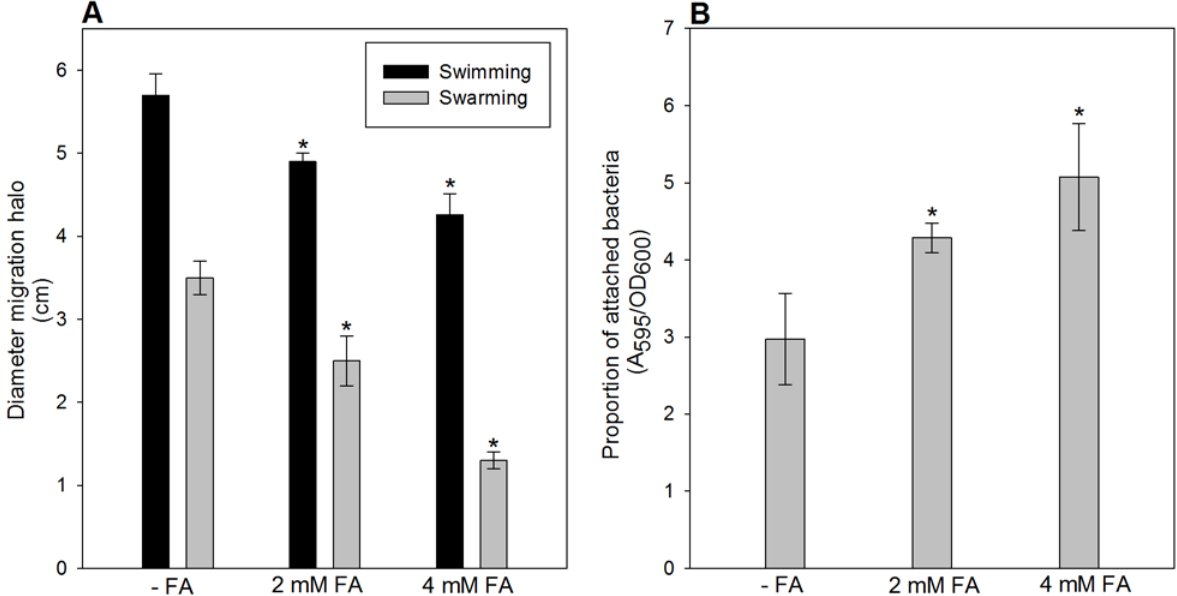
Figure 2. Effect of FA on cell motility and biofilm formation by P. protegens Pf-5. A . Cultures of P. protegens Pf-5 (wild type) were grown aerobically overnight to OD = 3 in KMB medium. An aliquot was spotted onto the centre of plates containing 20 fold diluted KMB medium supplemented or not with FA and solidified with various concentrations of Bacto-Agar, depending on which motility was to be evaluated. After 24 h of incubation at room temperature, the distance of the migration front from the point of inoculation was measured. B . Cultures of P. protegens Pf-5 were grown in 96-well polystyrene plates containing E 2 glucose minimal medium supplemented or not with FA. After 24 h of incubation, biofilm formation was assessed by the determining the proportion of attached and non-attached bacteria (A 595 /OD 600 ). In all cases, error bars indicate the standard deviation of the mean. The asterisk ( * ) denotes significant differences (P < 0.05) using